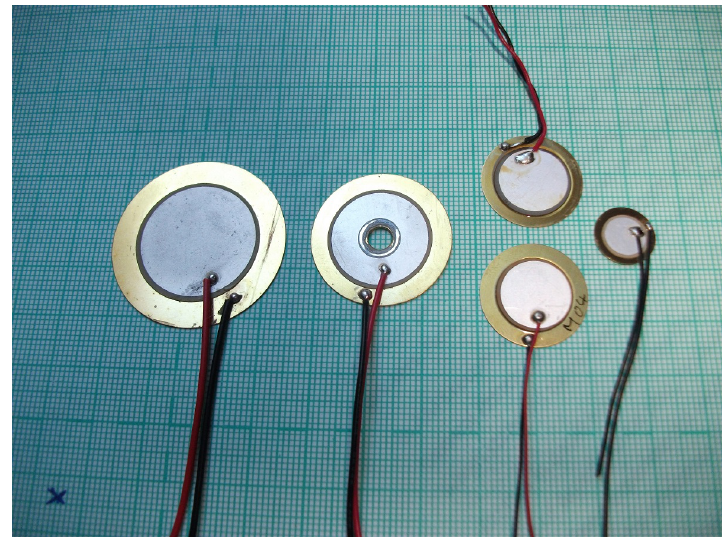
Figure 1. A selection of piezoelectric diaphragms, from left to right—35 mm diameter, 27 mm with drilled hole, 20 mm diameter salvaged unit from greeting card on top, Murata unit below, 12 mm salvaged unit on